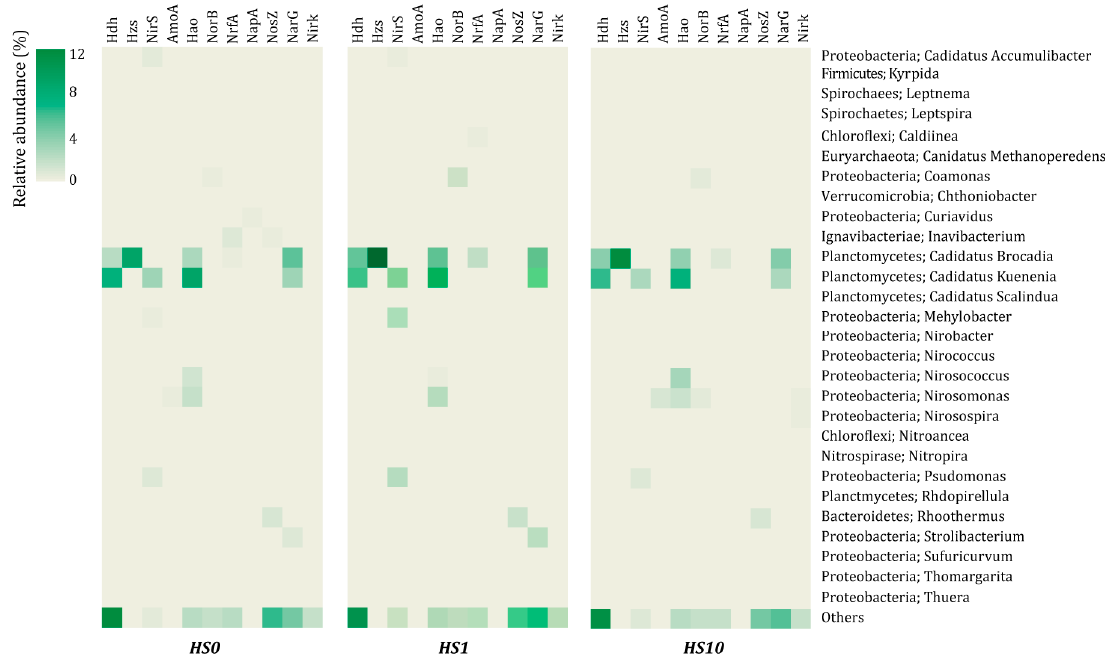
Figure 4. Taxonomic origins of the key enzymes in nitrogen metabolism based on metagenome sequences. amoA , bacterial ammonia monooxygenase subunit A; narG , cytoplasmic nitrate reductase alpha chain; napA , periplasmic nitrate reductase precursor; nirK , copper nitrite reductase; nirS , cytochrome cd1 nitrite reductase; norB , nitric oxide reductase subunit B; nosZ , nitrous oxide reductase; nrfA , ammonia-forming dissimilatory nitrite reductase; hzs , hydrazine synthase; hdh , hydrazine dehydrogenase. HS0, HS1 and HS10 indicate 0, 1 and 10 mg · L − 1 humic substances, respectively.